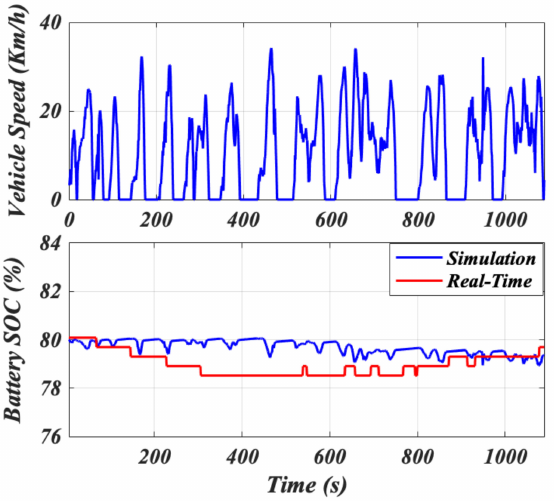
Figure 12. Real-time results of the speed profile and the battery